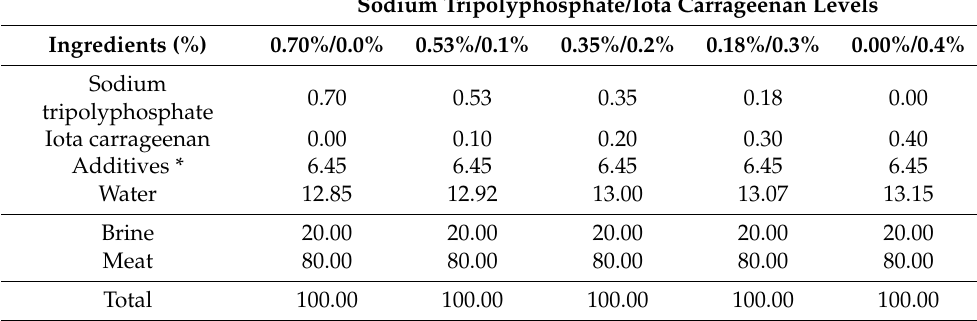
Table 1. Formulation of five ostrich ham